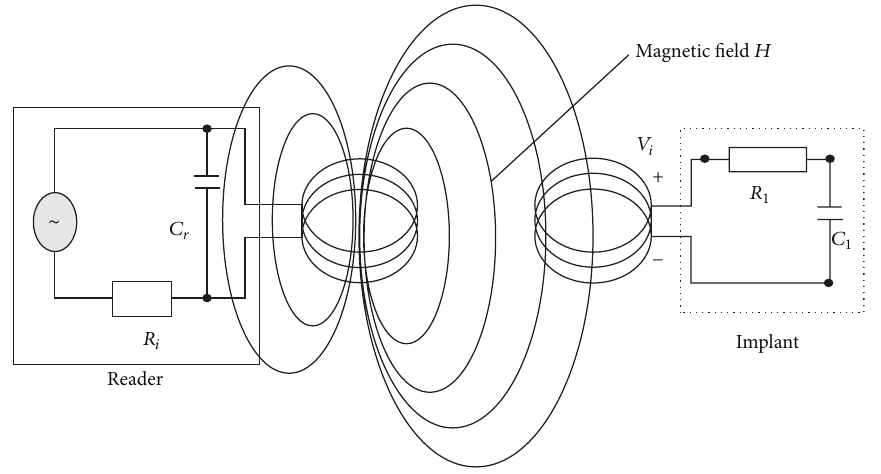
Figure 1: Transmission in a magnetic induction coupling